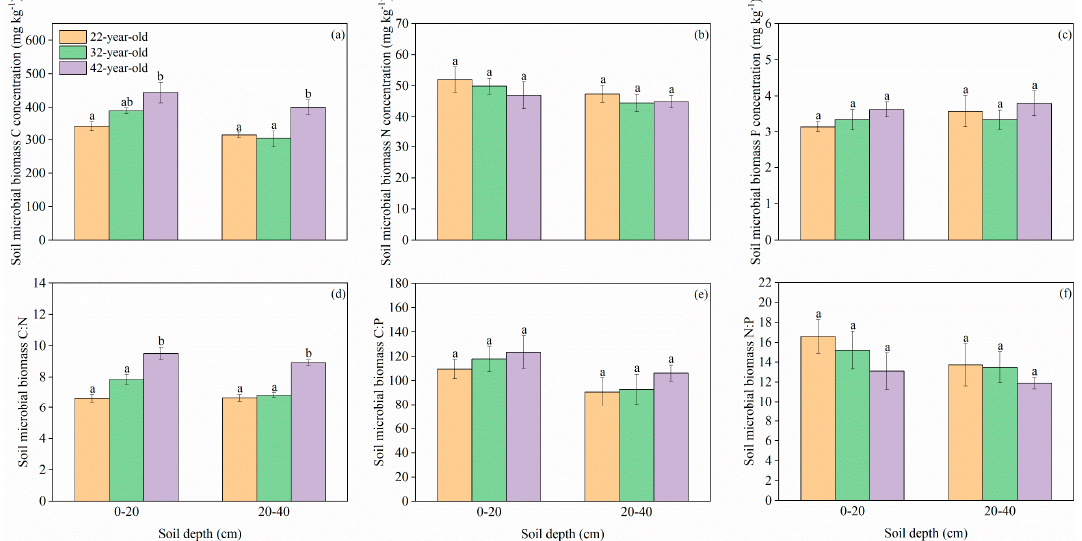
Figure 2. ( a ) C concentration), ( b ) N concentration, ( c ) P concentration, ( d ) C:N, ( e ) C:P, and ( f ) N:P in the soil microbes of three different aged P. asperata plantations. Different lowercase letters indicate a significant difference between different aged stands at the same soil horizon ( p < 0.05).